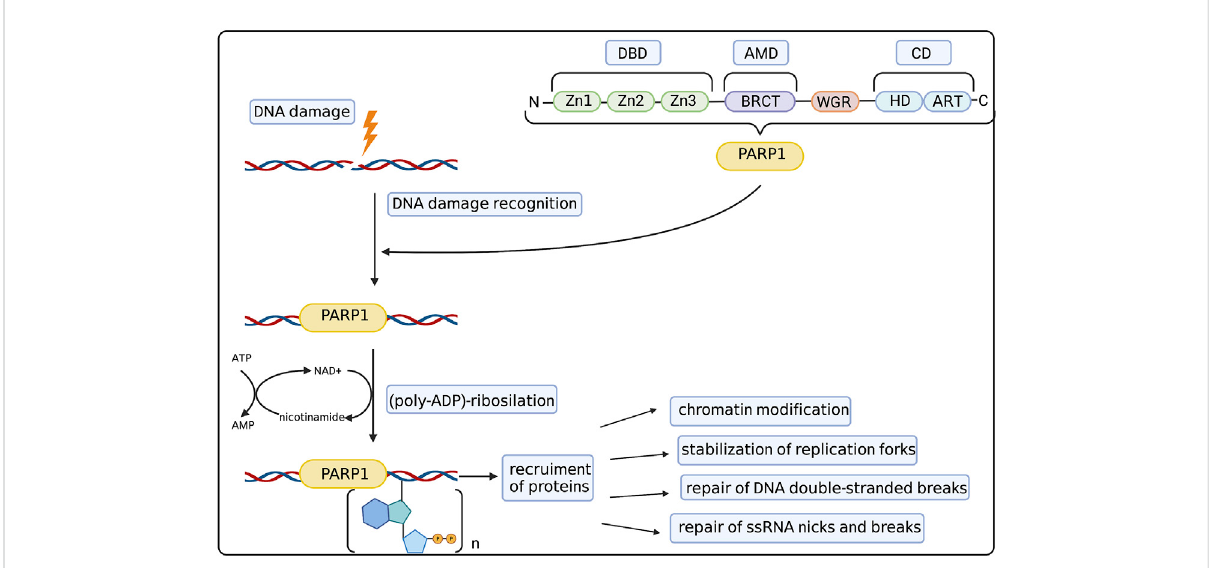
FIGURE 1 PARP1structureandmechanismofaction.PARP1moleculeconsistsof3maindomains:DNAbindingdomain(DBD)withzinc fi ngers(Zn1-Zn3), Automodi fi cation Domain (AMD) with BRCA1 C-terminus (BRCT) subdomain and catalytic domain (CD) with helical domain (HD) and C-terminal ADP-ribosyltransferase(ART)subdomain.TheWGRdomainconsistsoftheTrp-Gly-Argmotif.SuchstructureallowsPARP1torecognizeandbindto the DNA damage site. Then it catalyzes the (poly-ADP)-ribosylation process, allowing the recruitment of auxiliary proteins responsible for chromatin modi fi cation, stabilization of replication forks, repair of DSBs and repair of ssDNA nicks and breaks. Created with